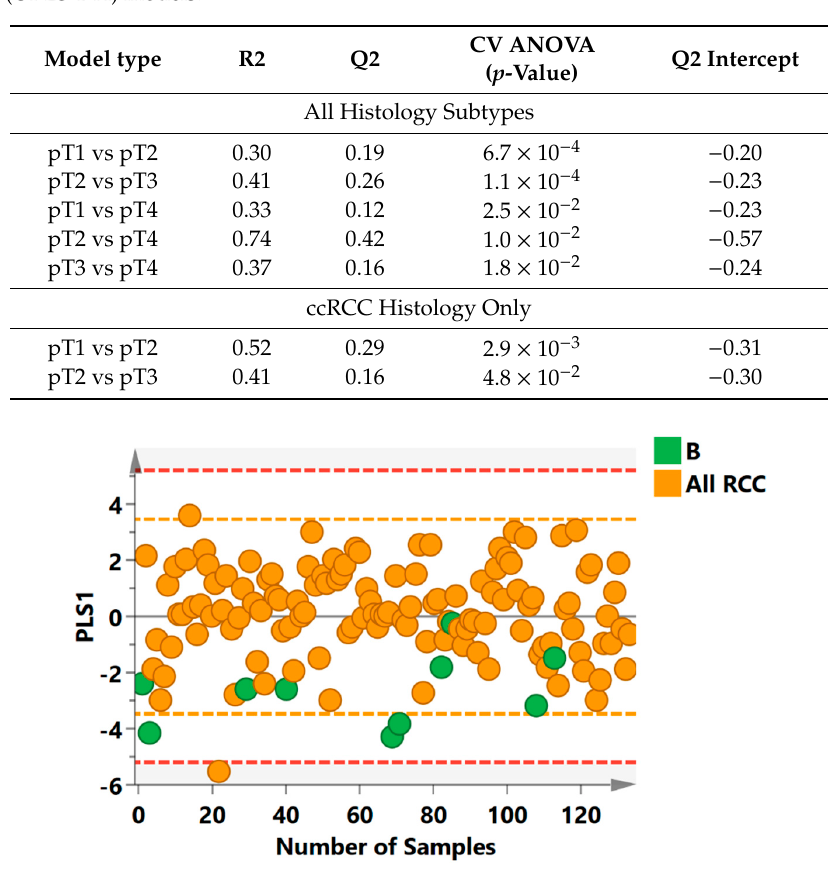
Figure A1. Orthogonal Partial Least Squares Discriminant Analysis (OPLS-DA) score scatter plot of benign lesions versus all histological subtypes; along their partial least squares component (PLS1). The orange and red dashed lines describe the 2SD and 3SD limits respectively.